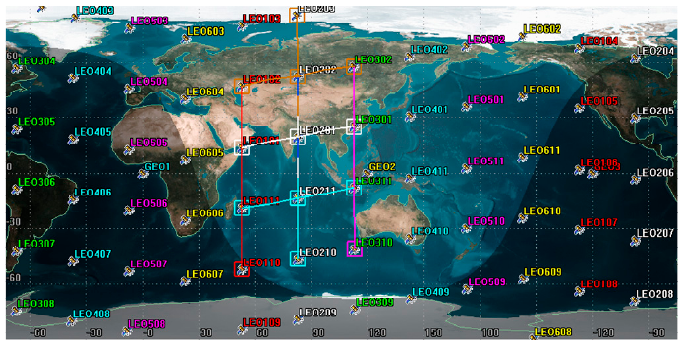
Figure 6. The 2D view of intersatellite link.